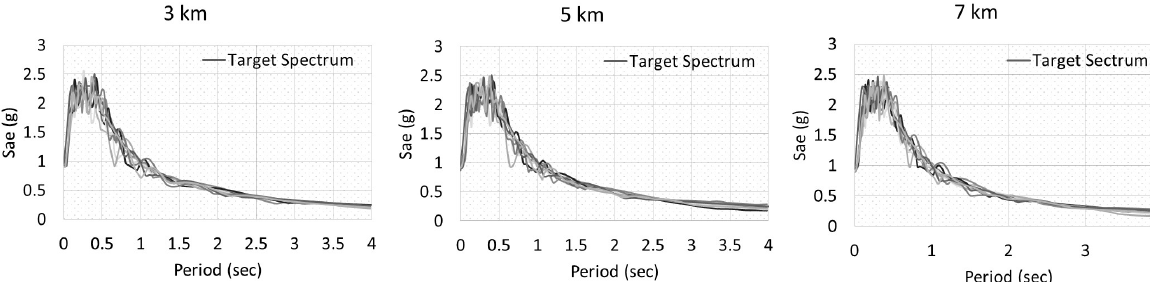
Figure 3. Comparison of target spectrum and generated near field ground motion data set for 3, 5 and 7 km.